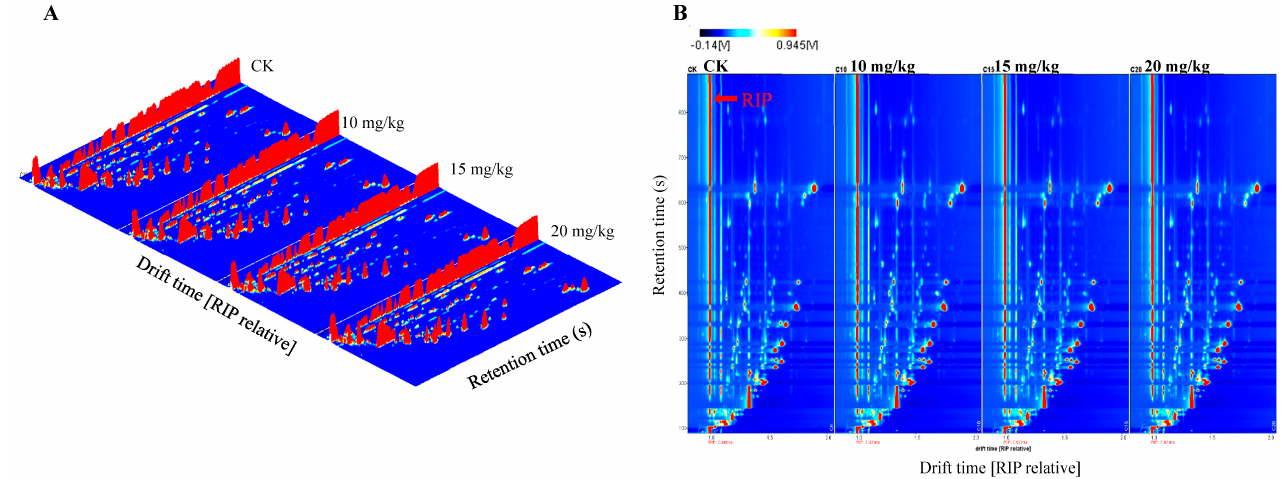
Figure 2. Volatile flavor compounds in fresh oriental melon after pollination or forchlorfenuron ap- plication: ( A ) a three-dimensional spectrum of the HS-GC-IMS response data; ( B ) a two-dimensional spectrum of the HS-GC-IMS response data.